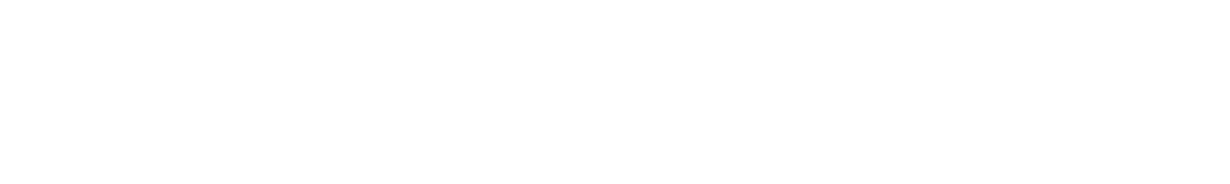
Frontiers in Psychology |